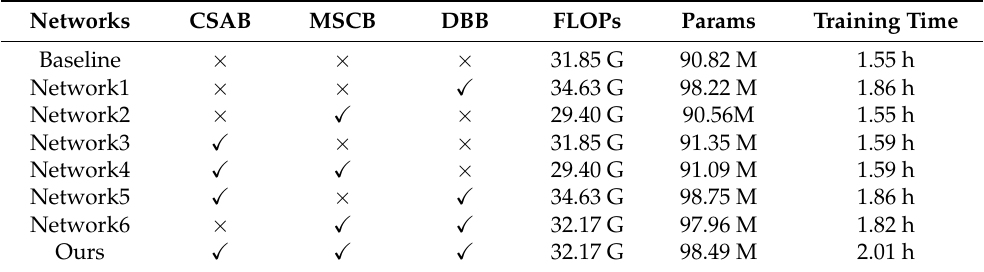
Table 10. Network complexity analysis of Res-CDD-Net and the baselines.